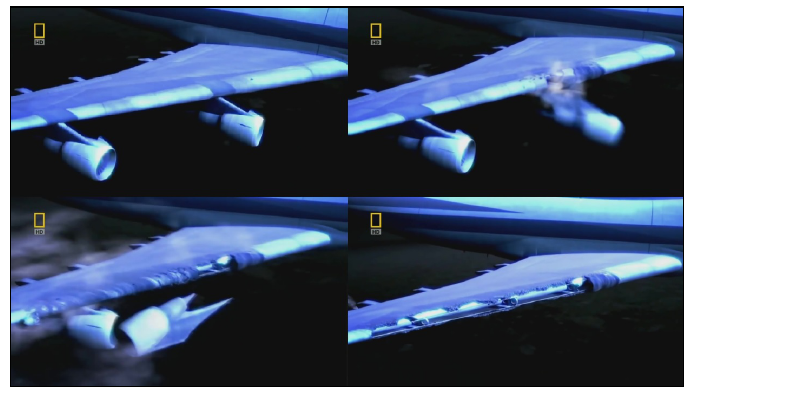
Figure 3 – Simulation of the El Al Flight 1862 crash in Amsterdam Рис . 3 – Моделирование аварии самолета El Al Flight 1862 в Амстердаме Slika 3 – Simulacija udesa aviona na letu 1862 avio-kompanije El Al u